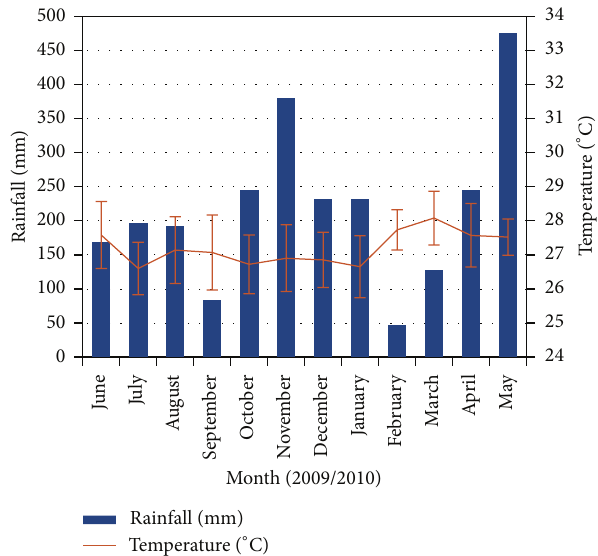
Figure 4: Total rainfall (mm) and air temperature ( ∘ C) ± S.E June 2009–May 2010.